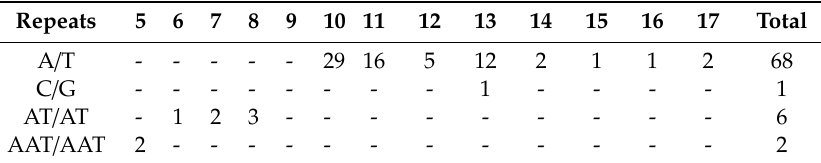
Table 4. Summary of the number of individual types of SSRs identified in cp genome of D. draco. (including complementary